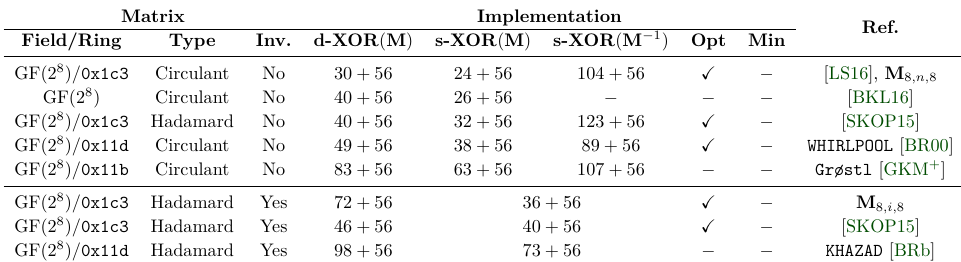
Table 6: Comparison of 8 × 8 MDS matrices over GF(2 8